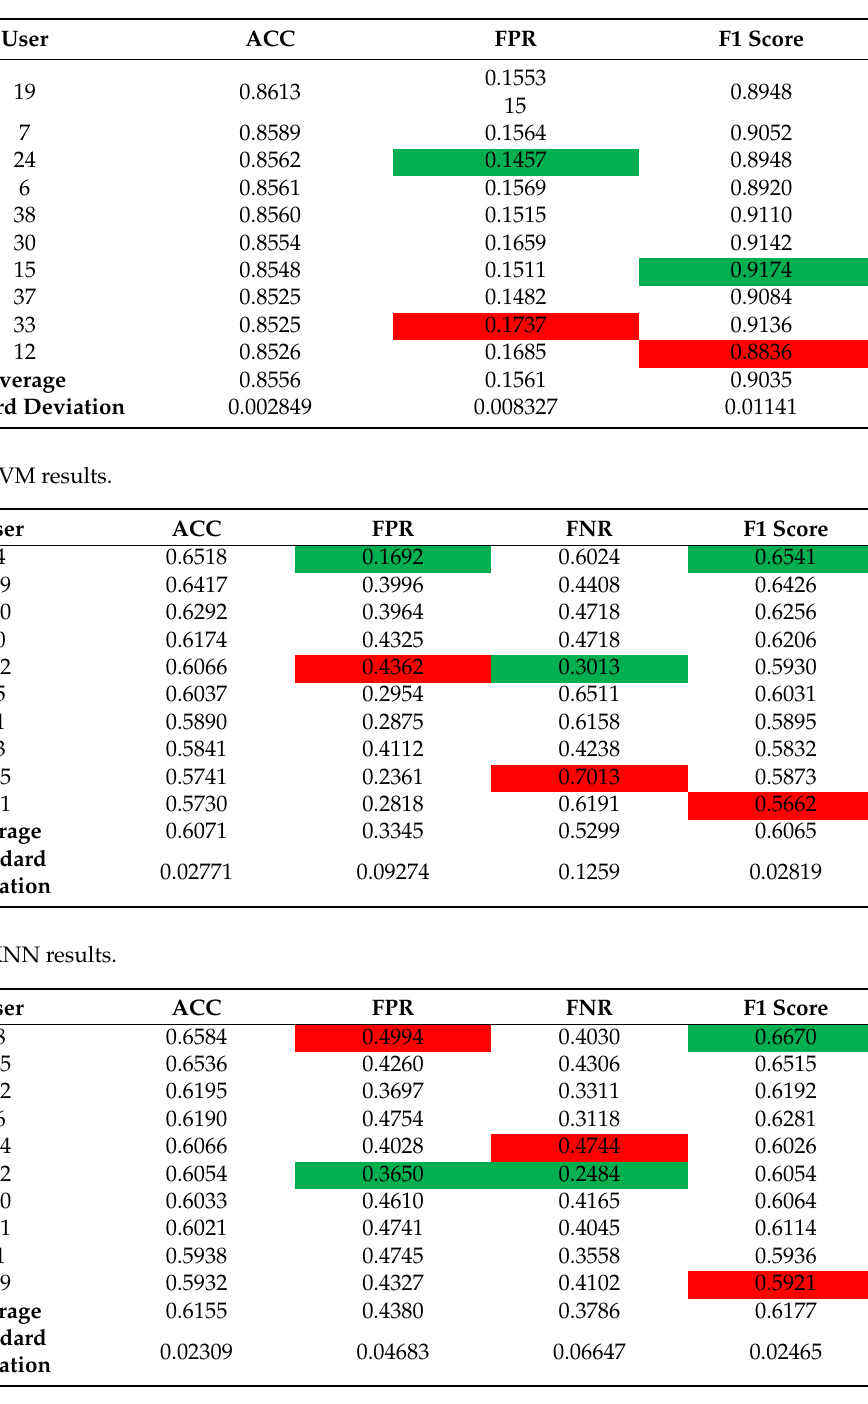
Table 3. LSTM-RNN results.